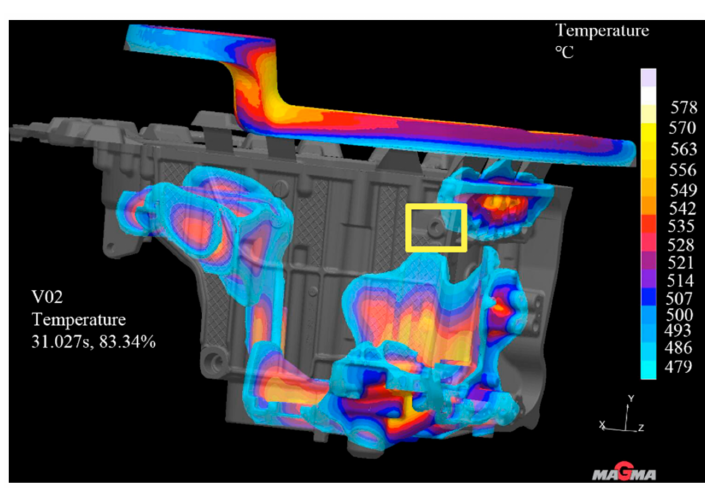
Figure 12. Improved solidification cloud